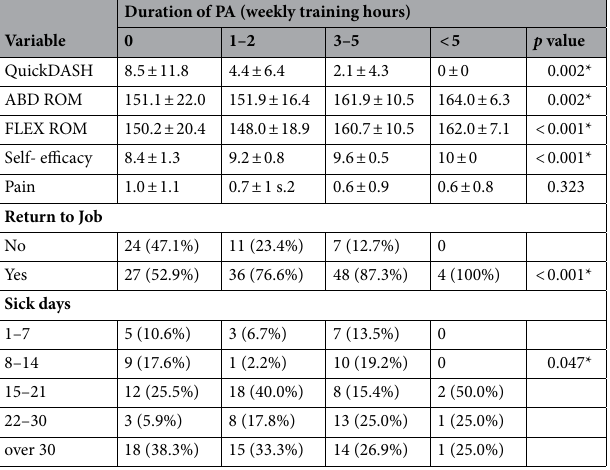
Table 3. The influence of frequency of physical activities. Continuous variables are presented as mean and standard deviation (SD) and categorical variables are presented as number and percentage. Significant p value* p ≤ 0.05. PA, Physical activity; ABD, Abduction; FLEX, Flexion; ROM, Range of motion; NPRS, Numeric pain rating scale.